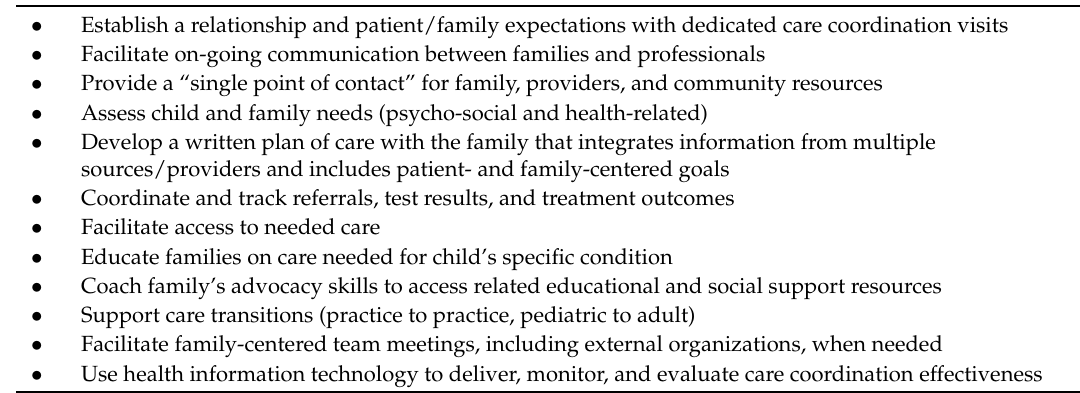
Table 1. Evidence-based functions of care coordination